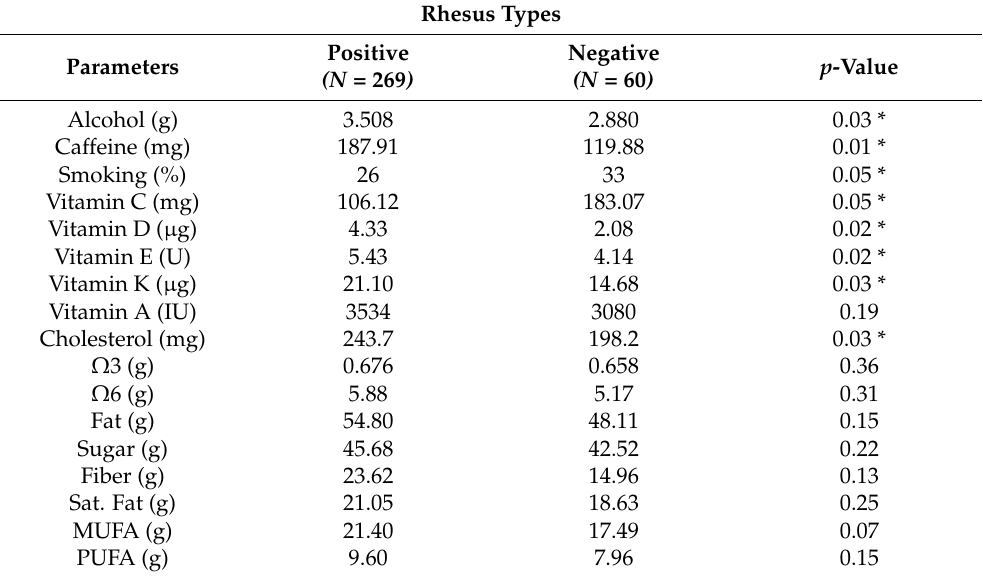
Table 3. Correlation between rhesus types and preferences in study population. Statistically signifi- cant differences are presented with